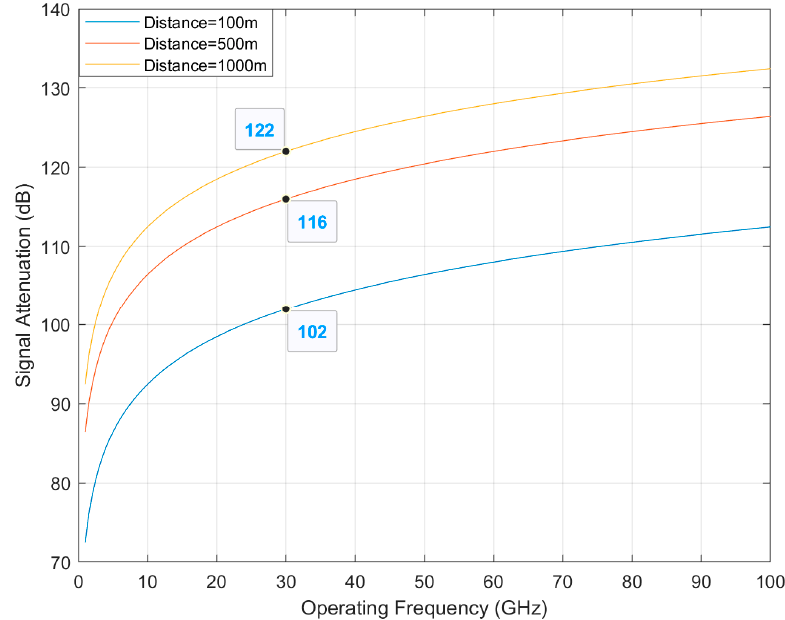
Figure 13. Free space propagation loss for different operating frequency.